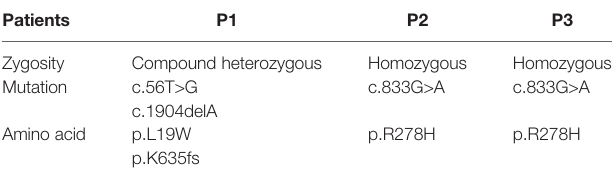
TABLE 2 | Genetic results from all 3 patients.